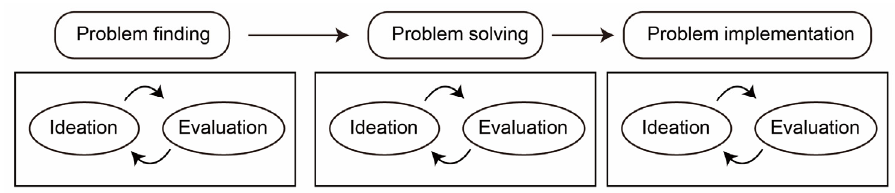
Figure 7. The ideation–evaluation cycle.